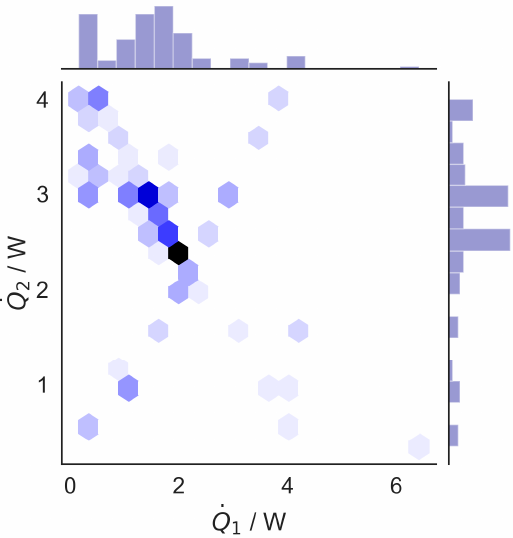
Figure 3. Overview of the distribution of data with different power settings in the final dataset. Darker color corresponds to a higher amount of datapoints in the respective region, as also indicated by the bar plots.